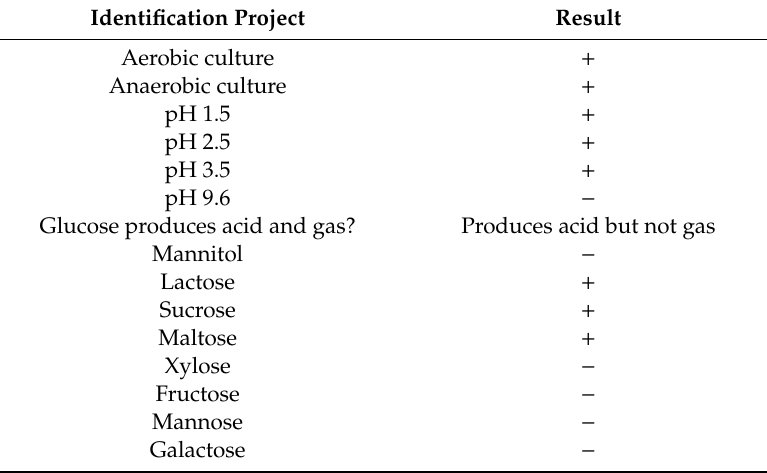
Table A1. Biochemical identification results for